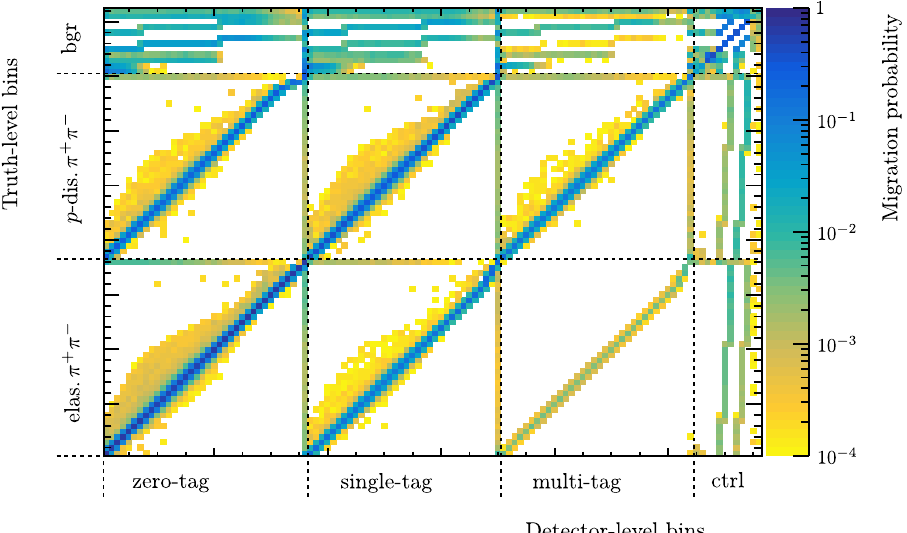
Fig. 5 Response matrix for unfolding the one-dimensional m rec ππ dis- tributions. The matrix depicts migration probabilities from bins of the truth-level distributions along the y axis into bins of the detector-level distributions along the x axis. On detector-level, m rec ππ distributions in the forward tagging categories are considered, and on truth-level, m ππ